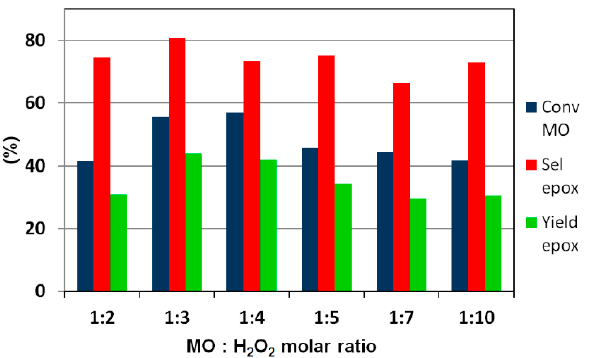
Figure 5. Influence of the alkene to H 2 O 2 ratio on the epoxidation of pure methyl oleate (MO) over NbO x -SiO 2 . Conditions: 100 mg catalyst, 1 mmol MO, aq. H 2 O 2 , 90 °C, 4 h, 300 rpm, 5 mL CH 3 CN.